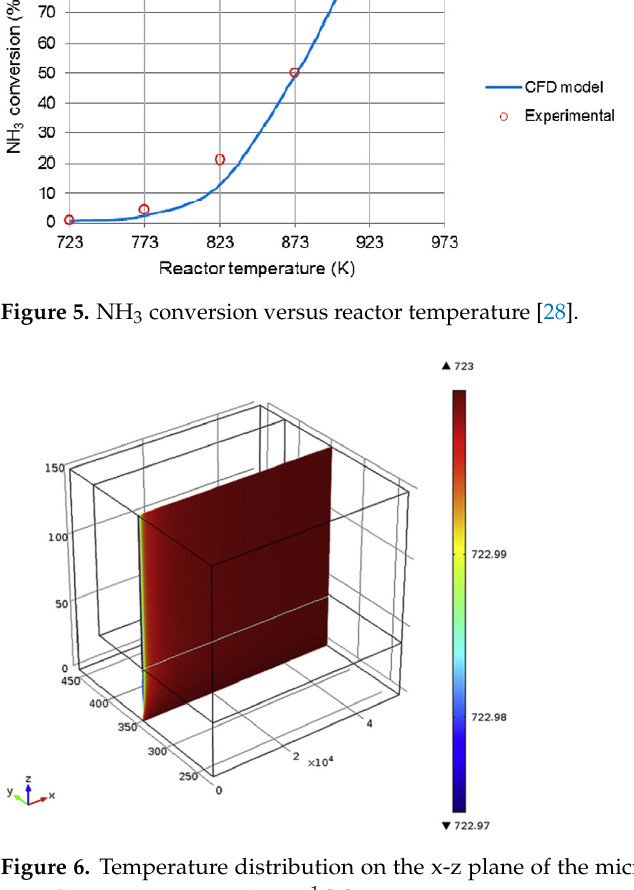
NH 3 flow rate (>100 Nml·min − 1 ), but H 2 production was increased. Pressure can also affect NH 3 decomposition. The decrease in total pressure will pro- mote NH 3 decomposition and increase NH 3 conversion. The presence of hydrogen inhibits NH 3 decomposition, and the NH 3 decomposition rate increases as the hydrogen partial pressure decreases [29,30]. Membrane reactors take advantage of this feature to improve NH 3 conversion, which is discussed further in Section 6. 3.2.2. Effect of Mass Transfer For characterizing the rates of mass transfer in the porous area and reaction, Maleki et al. [19] defined some characteristic time scales and dimensionless numbers as listed in Table 1. Both 𝐷𝑎 II and 𝜙 are less than 1 in their study, which shows that the molecular diffusion time scale is smaller than the chemical reaction time. Figure 8 further depicts kinetic control region and mass transfer control region by 𝑃𝑒 and 𝐷𝑎 II . In the microreactor proposed by Maleki et al. [19], the decomposition reaction occurs in the kinetic control region, which is not restricted by mass transport. Table 1. Definitions and values of characteristic time scales and dimensionless numbers for the mi- croreactor proposed by Maleki et al. [19]. Name